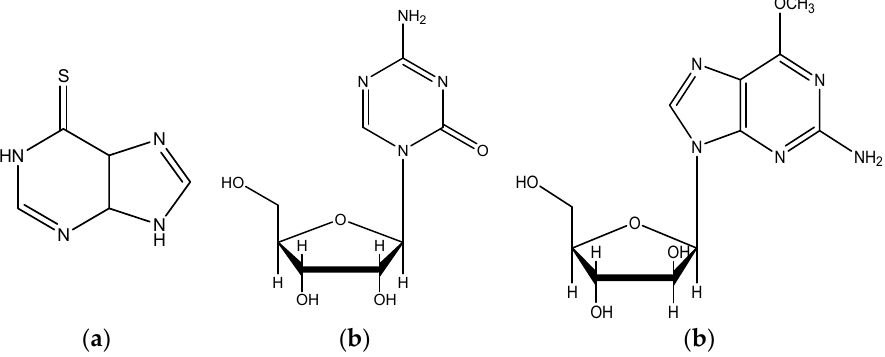
Figure 1. ( a ) 6-mercaptopurine, ( b ) azacitidine, and ( c ) nelarabine act as nucleic acid synthesis inhibitors and have been approved as anticancer drugs by the Food and Drug Administration (FDA0.